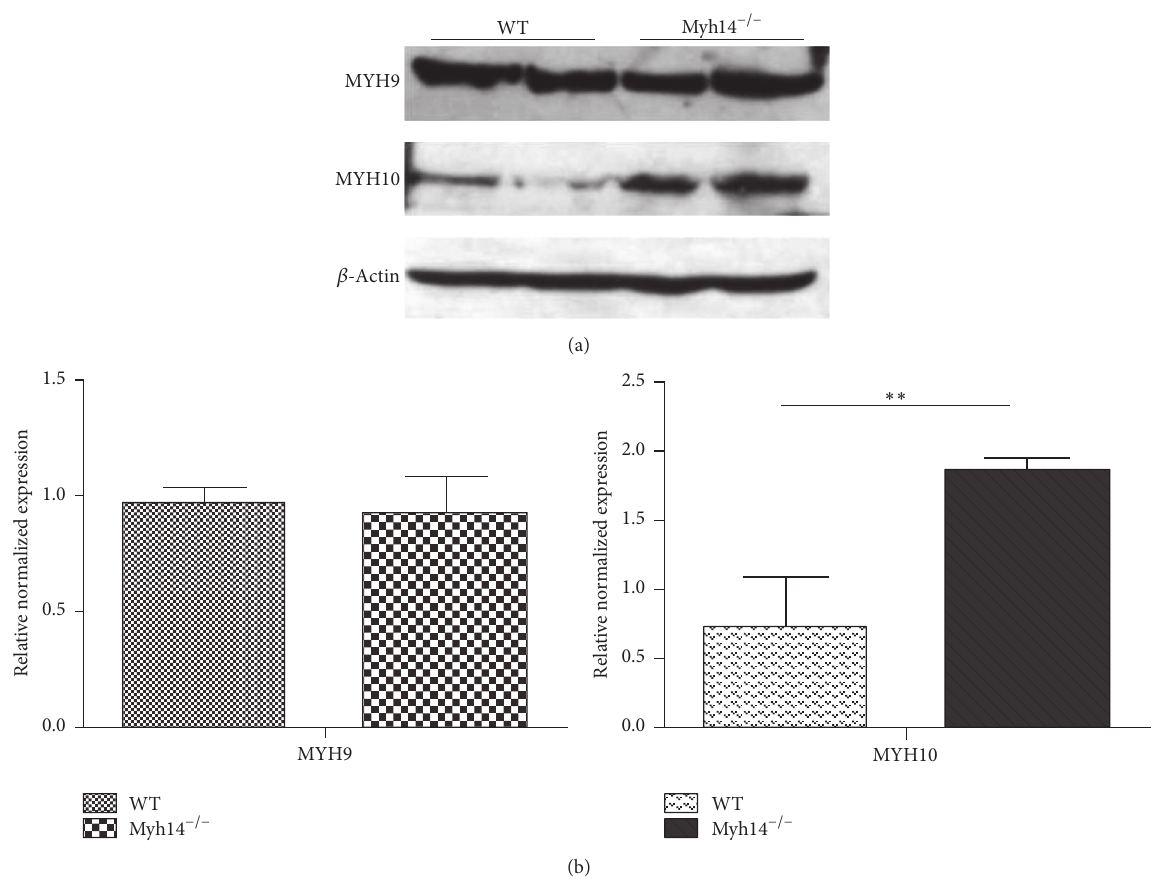
Figure5:ExpressionofMYH10isupregulatedinthecochleaeofMyh14 −/− mice.((a),(b))Westernblotanalysisof3-month-oldmiceindicates that the expression of MYH10, not MYH9, is upregulated in the cochleae of Myh14 −/− mice compared to controls ( 𝑛 = 3 for each group). ∗∗ 𝑃 < 0.01 by Student’s 𝑡 -test.